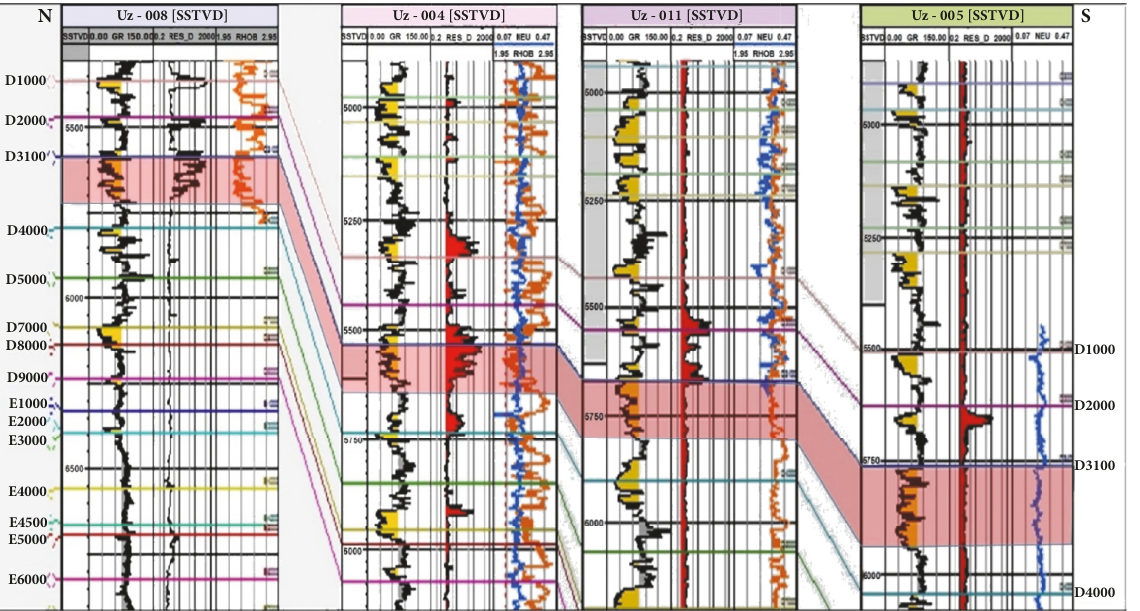
Figure 3: Correlation of reservoir interval D3100 package across wells within the study area (Note that reservoir packages interval thickens from North to South across